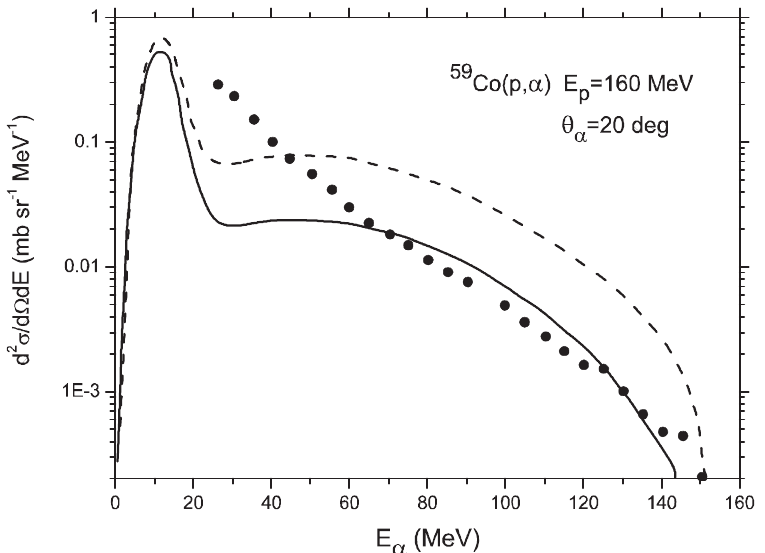
Fig. 2. Double differential cross section distribution for the 59 Co(p, αx) reaction at an incident energy of 160 MeV. The experimental data of Cowley et al. [6] are shown with error bars which are smaller than the symbol size. The curves represent pre-equilibrium calculations by Bevilacqua [5] with default TALYS [3] input (dashed line) and with the knockout component switched off (solid